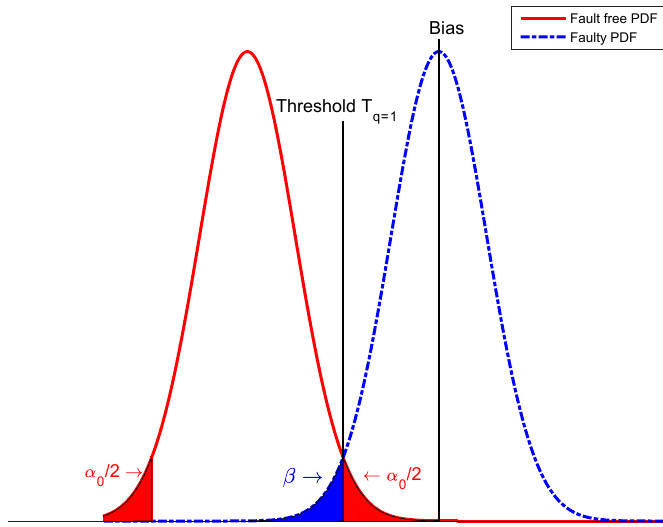
Figure 2. Probability density function (PDF) of the unbiased and biased normal distributions in the local test.